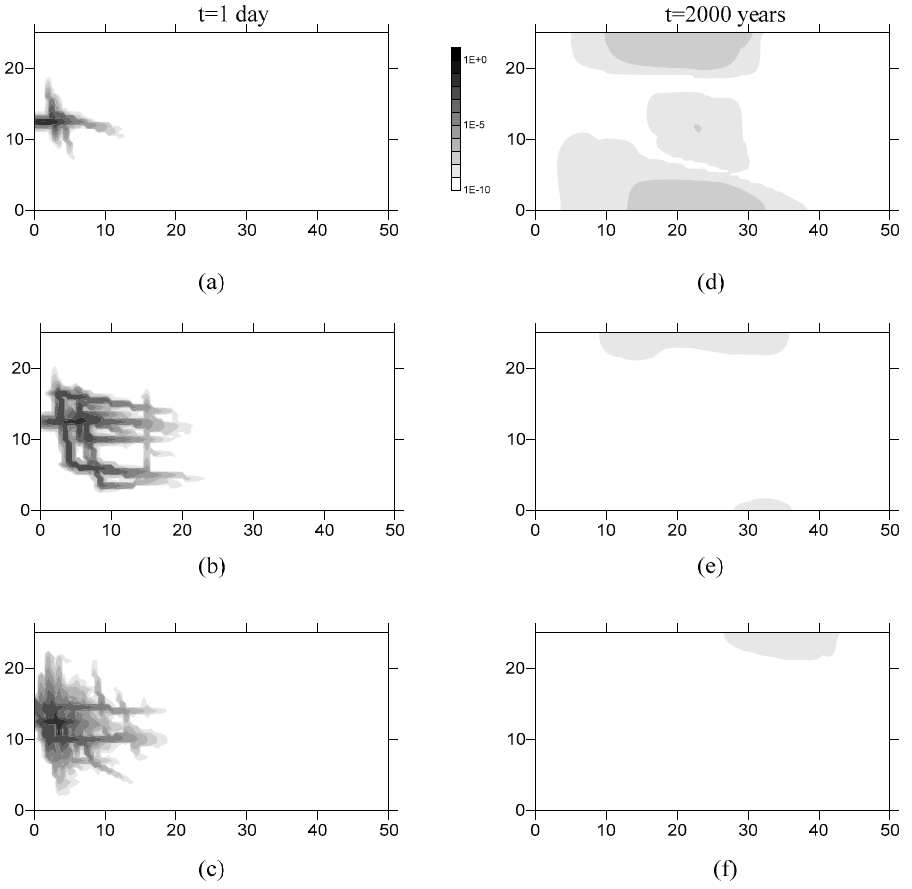
Figure 5. Monte Carlo results of plume snapshots for the first time step ( t = 1 day) for the three different fracture densities: the DFNs with ( a ) 20 fractures; ( b ) 60 fractures and ( c ) 80 fractures. The 13th time step ( t = 2000 years) for the three different fracture densities: ( d ) 20 fractures; ( e ) 60 fractures and ( f ) 80 fractures.